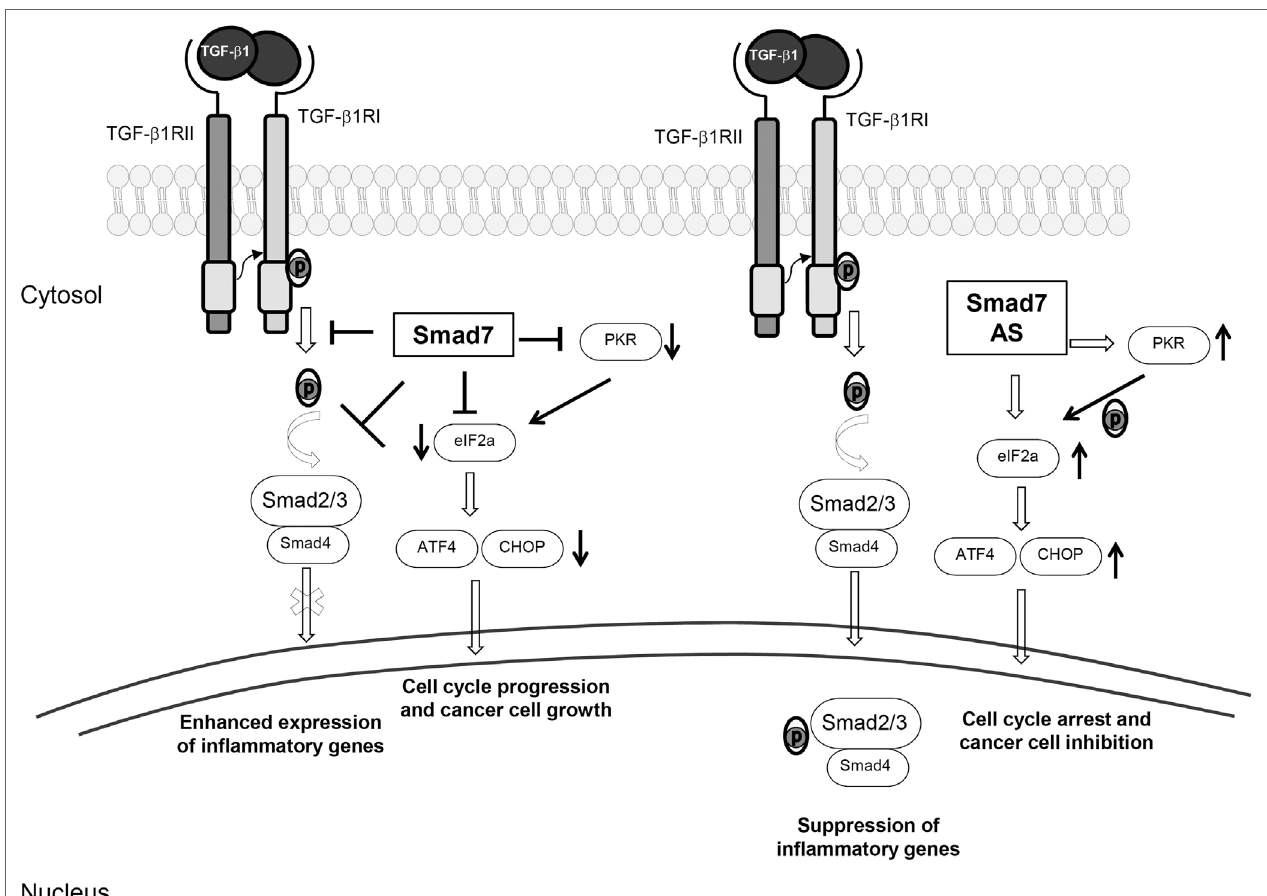
FiGURe 1 | Smad7-induced biological effects . The left side of the figure shows the inhibitory effect of Smad7 on transforming growth factor (TGF)- β 1 intracellular signaling. Smad7 binds to TGF- β receptor type I and prevents TGF- β 1-driven Smad2/3 phosphorylation (p), thus sustaining inflammatory gene expression. High Smad7 prevents also eukaryotic translation initiation factor-2 α (eIF2 α ) phosphorylation, either directly or through the inhibition of protein kinase RNA (PKR), thereby leading to downregulation of transcription factor 4 (ATF4) and CCAAT/enhancer binding protein homology protein (CHOP) with the down-stream effect of stimulating cell cycle progression and cancer cell growth. The right side of the figure shows the effect of Smad7 inhibition with a specific antisense oligonucleotide (AS). Smad7 inhibition restores TGF- β 1-induced Smad2/3 phosphorylation, subsequent interaction of these two proteins with Smad4 and translocation of Smad2/3/4 complex to the nucleus, thereby suppressing inflammatory gene expression. Moreover, Smad7 knockdown causes TGF- β 1-independent eIF2 α phosphorylation, upregulation of ATF4 and CHOP with the down-stream effect of cell cycle